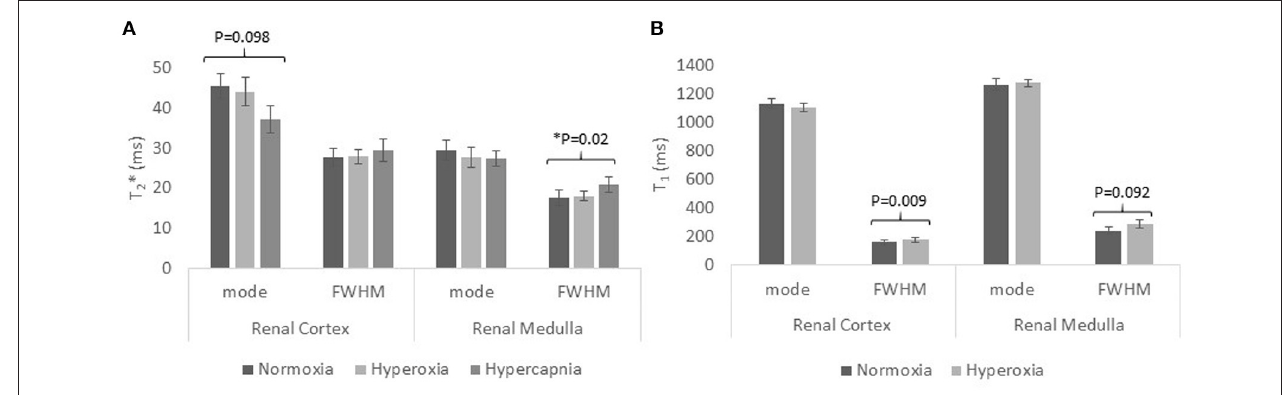
FIGURE 5 | The mode and FWHM (full-width-at-half-maximum) in the renal cortex and medulla of healthy participants for (A) transverse relaxation time T 2 * during normoxia, hyperoxia, and hypercapnia; (B) longitudinal relaxation time T 1 during normoxia and hyperoxia.